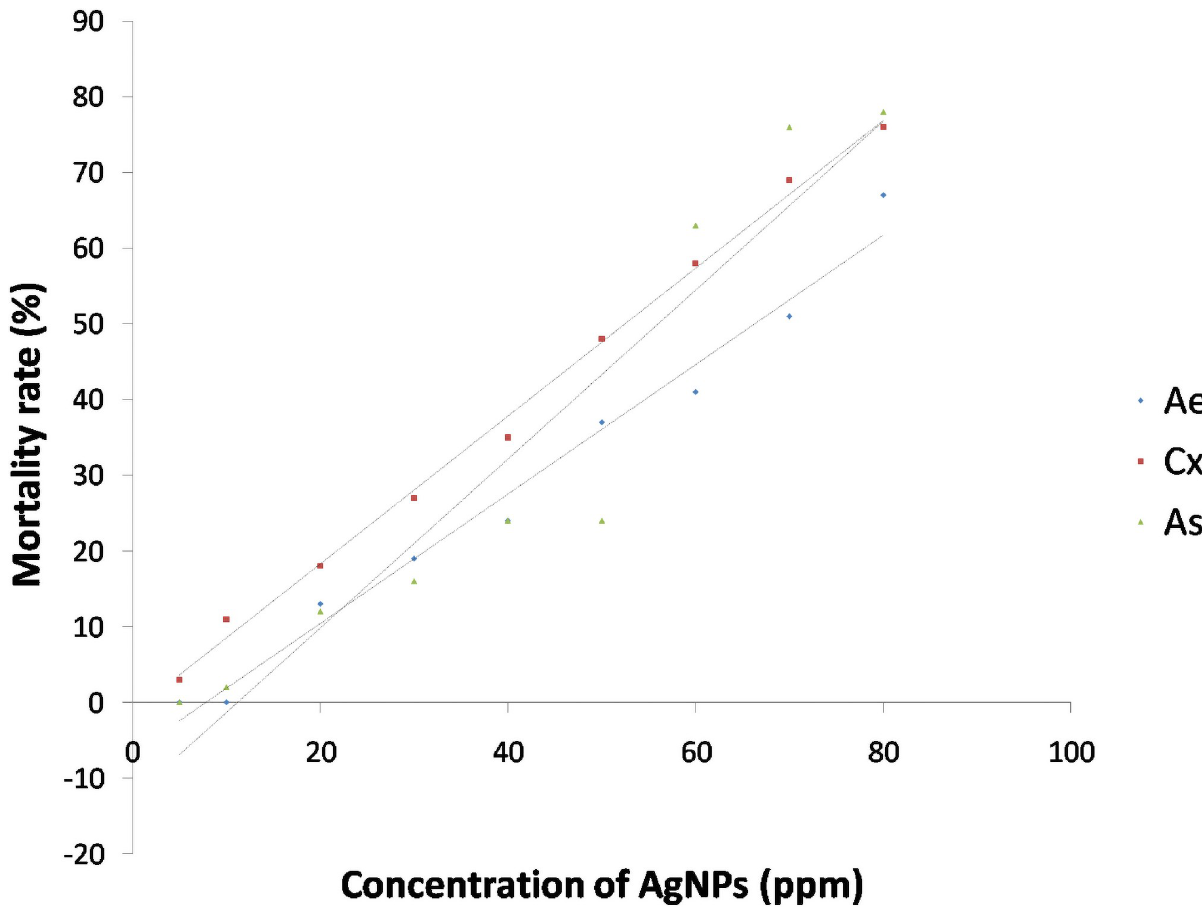
Fig 12. Mortality curves for larvicidal activity of AgNPs synthesized by Bacillus marisflavi against 3 rd instar larvae of Ae . aegypti , Cx . quinquefasciatus and An . Stephensi